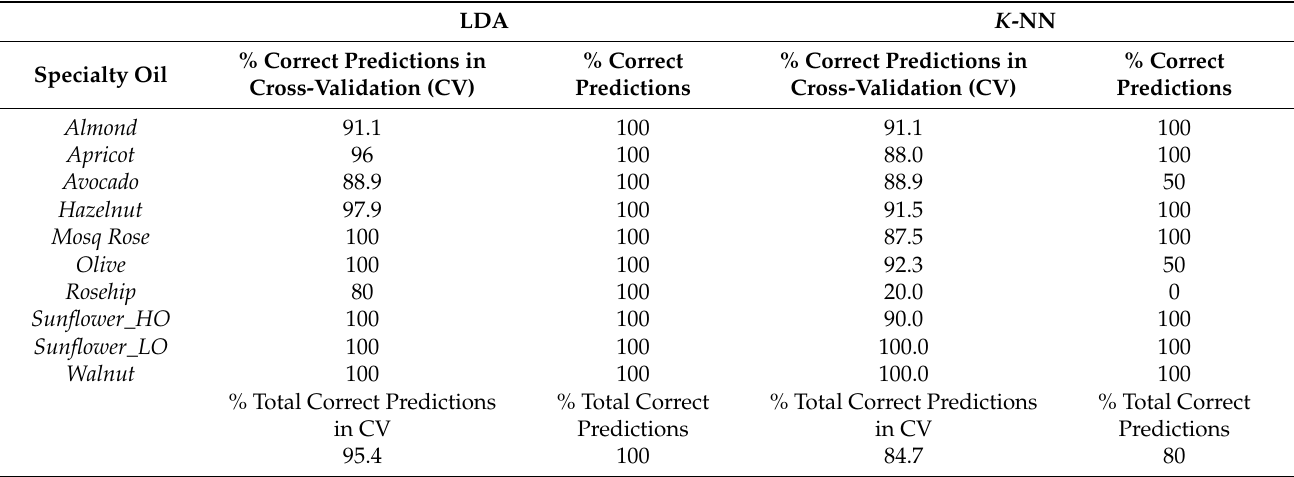
Table 3. Linear Discriminant Analysis (LDA) and K -Nearest Neighbors ( K -NN, k = 5) classification results.